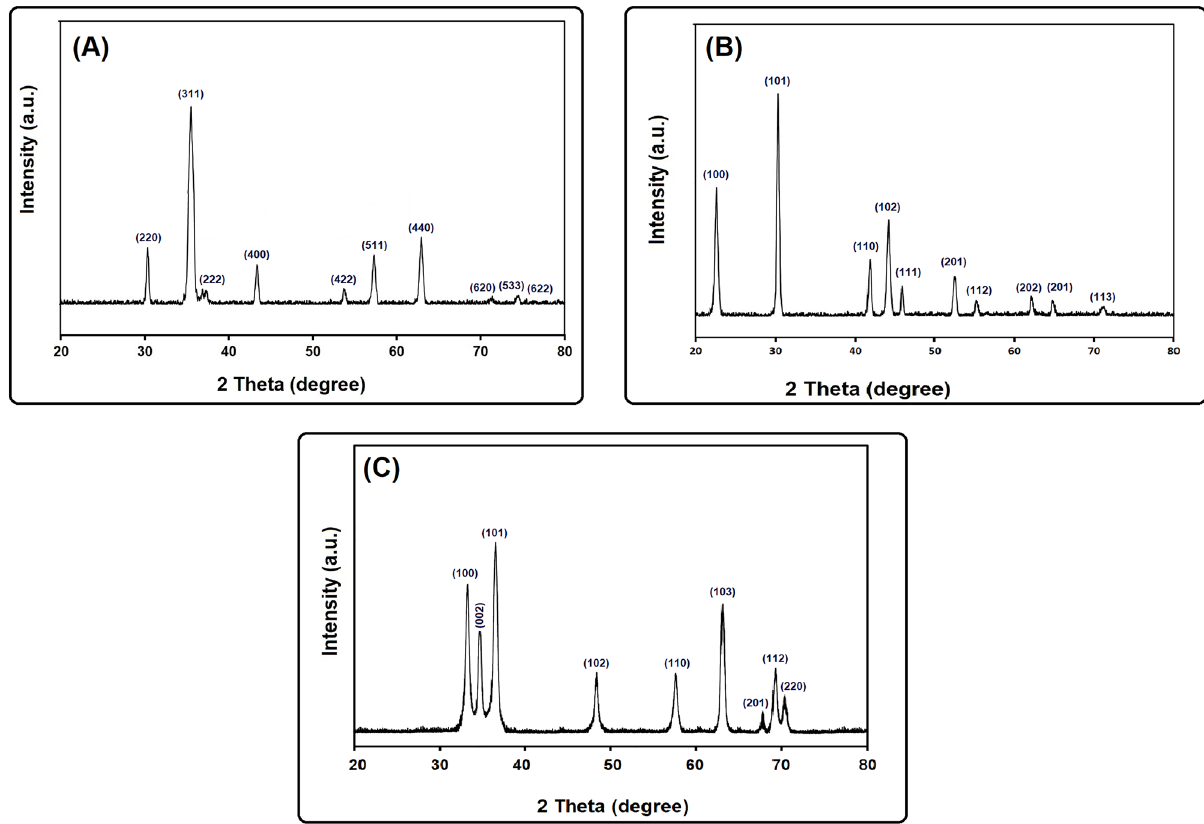
Figure 1. X-ray diffraction pattern (Cu Kα-radiation) at room temperature of the myco-fabricated CoFeNPs ( A ), SeNPs ( b ), and ZnONPs ( C ).